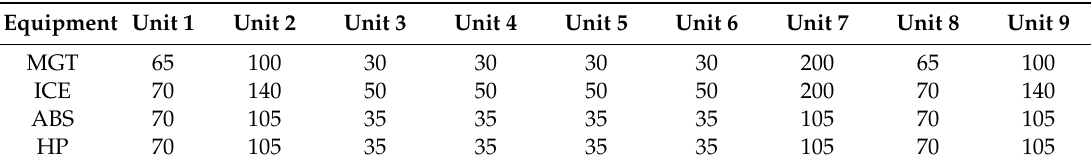
Table 2. Component sizes